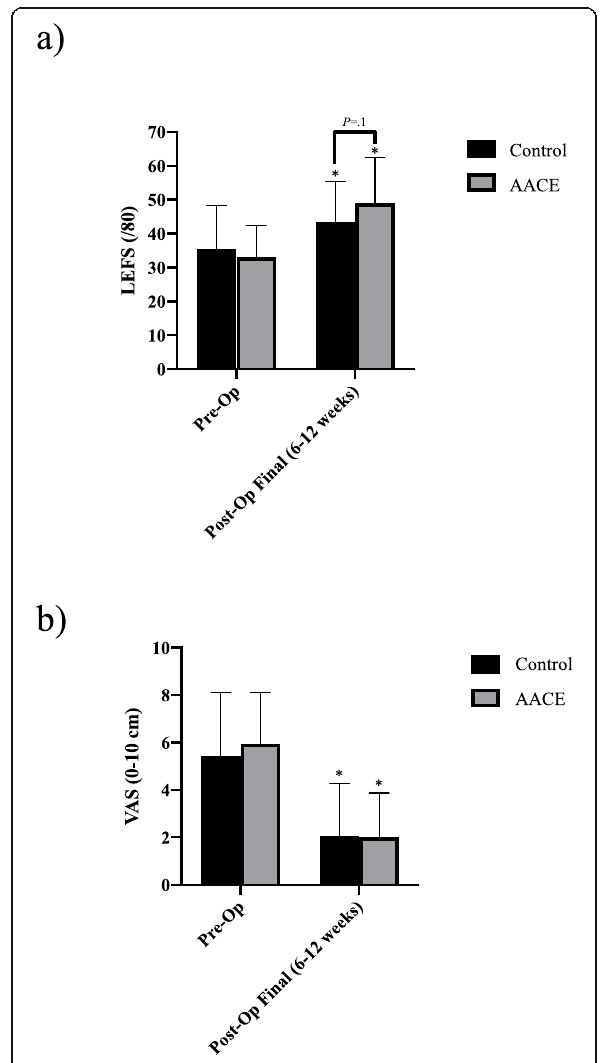
Fig. 3 Self-Reported Knee Function. A ) Lower extremity functional scale score for pre-op and post-op measures in the control and active assisted cycle ergometer (AACE) groups. * denotes significant difference from corresponding pre-operative measures. n = 24 – 26 per group. B ) Visual analog pain pre-op and post-op measures in the control and active assisted cycle ergometer (AACE) groups. * denotes significant difference from corresponding pre-operative measures. n = 25 – 26 per